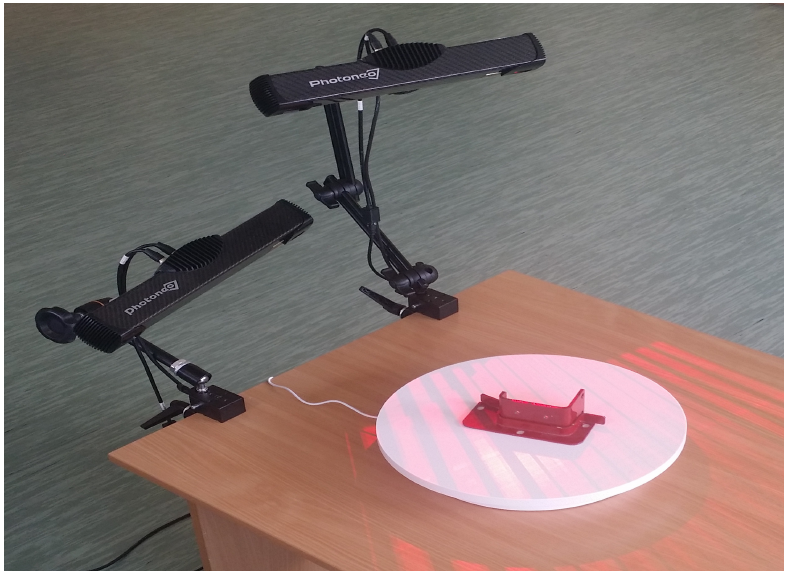
Figure 8. Photo of the scanner.